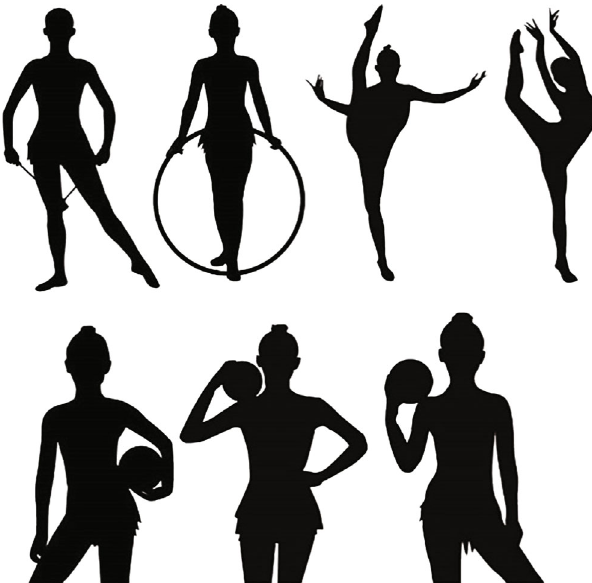
Figure 2: Common aerobics movement diagram.